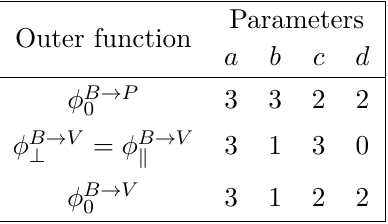
Table 5 . Parameters of the outer functions eq.